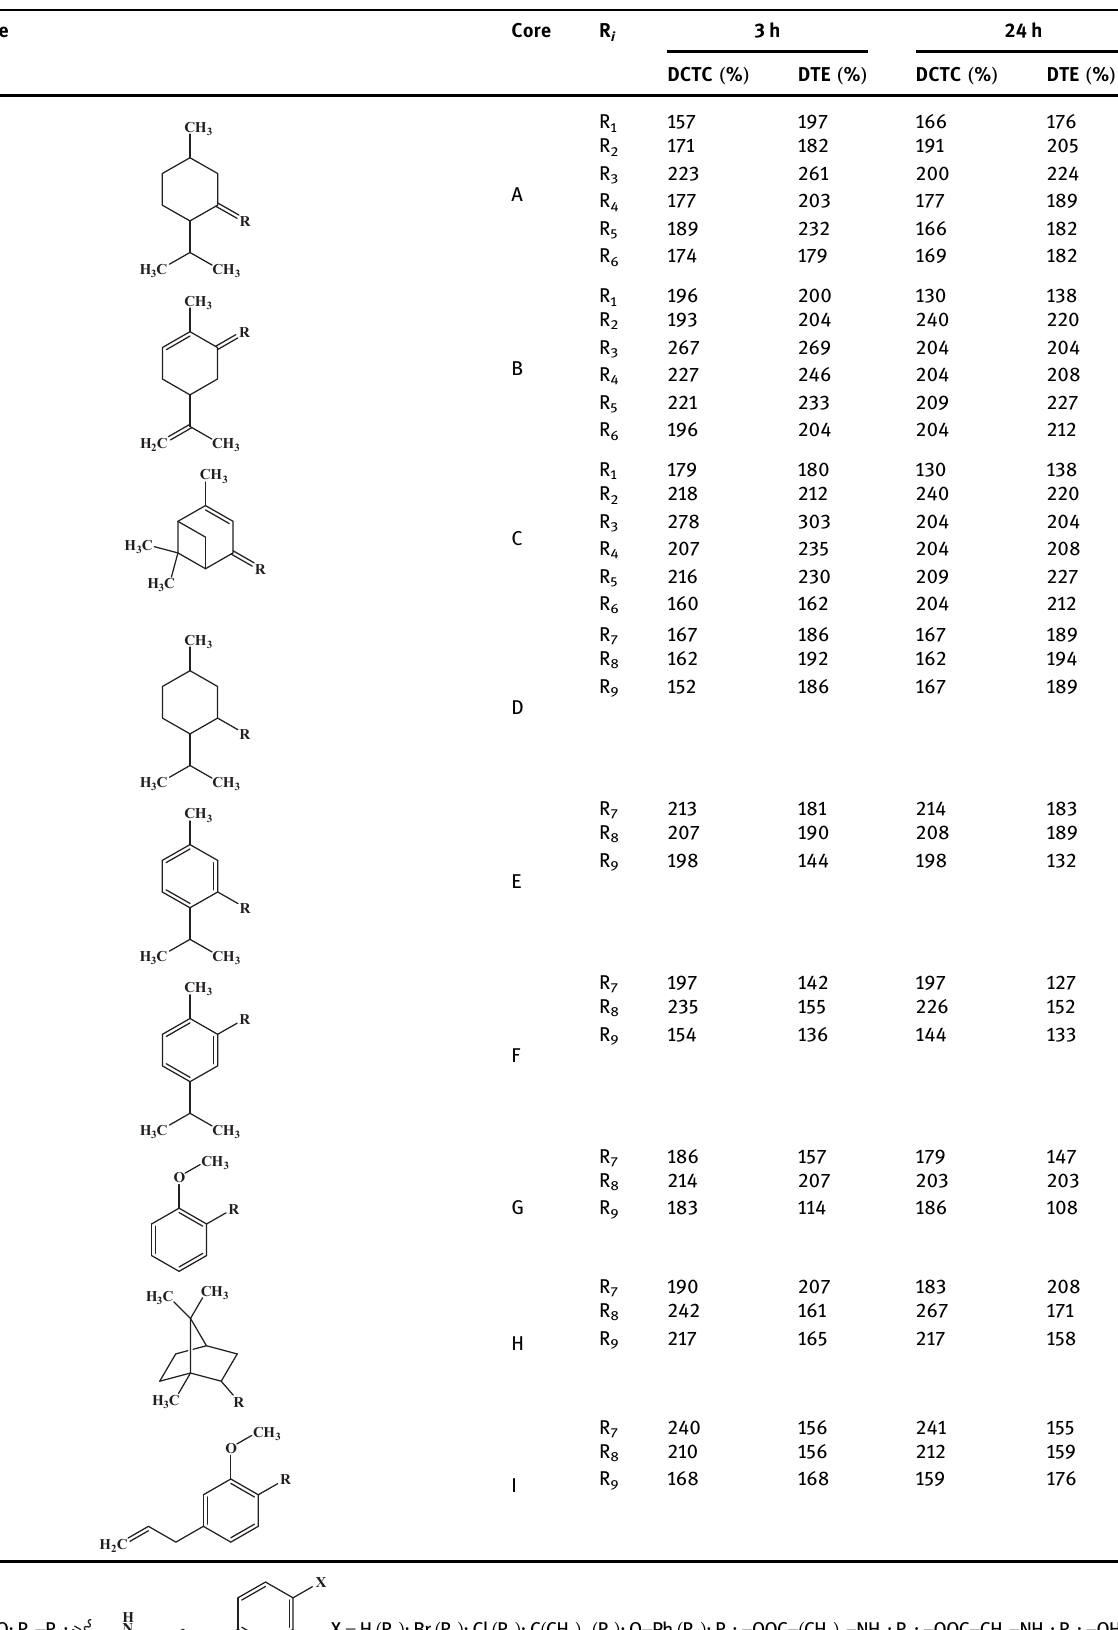
Table 1: Structures and anticonvulsant activities of terpenes and their derivatives